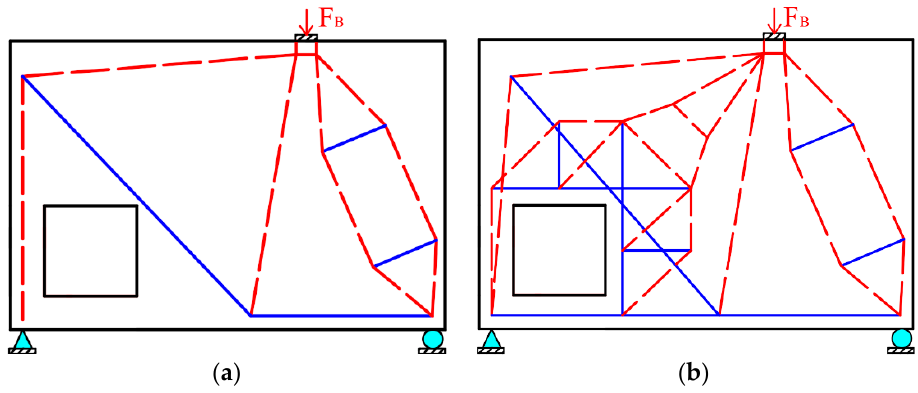
Figure 9. Optimal STMs proposed by Maxwell and Breen: ( a ) STM B-02; ( b ) STM B-03.